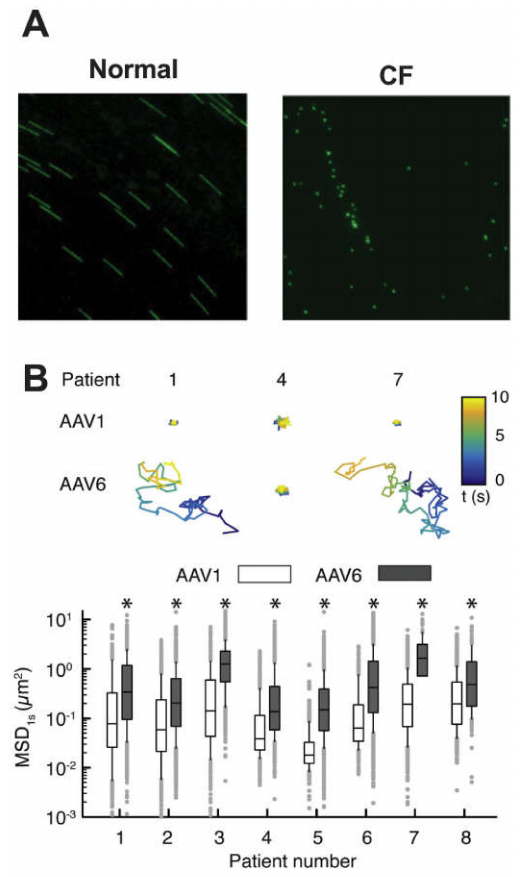
Figure 3. Probing the extracellular barrier: ( A ) Representative 2 s exposure image of fluorescent microspheres to illustrate mucociliary transport on normal and CF human tracheobronchial epithelial cell cultures. Reprinted with permission from Button, B.; Picher, M.; Boucher, R. “Di ff erential e ff ects of cyclic and constant stress on ATP release and mucociliary transport by human airway epithelia”. The Journal of Physiology 2007, 580(2), 577-592. Copyright 2007, The Physiological Society [285]. ( B ) Trajectories and mean squared displacement (MSD) of adeno-associated virus serotype 1 (AAV1) and adeno-associated virus serotype 6 (AAV6) in sputum samples from CF patients, * p < 0.05; Mann-Whitney test. Reprinted with permission from Duncan, G.; Kim, N.; Colon-Cortes, Y.; Rodriguez, J.; Mazur, M.; Birket, S.; Rowe, S.; West, N.; Livraghi-Butrico, A.; Boucher, R.; Hanes, J.; Aslanidi, G.; and Suk,